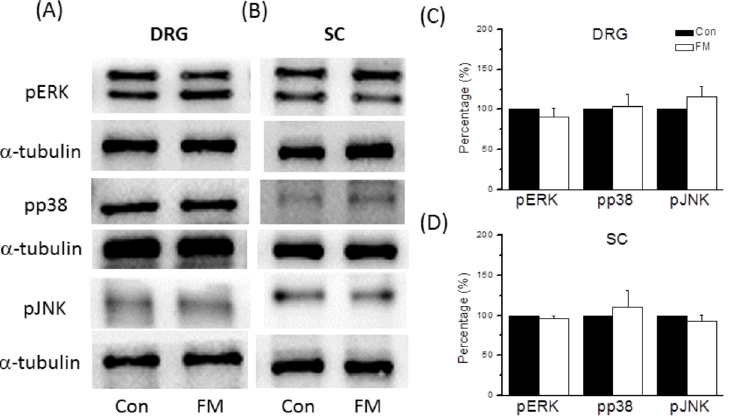
Fig 8. Expression levels of pERK, pp38, and pJNK in L3-L5 DRG from TRPV1 null mice. (A) Western blots of DRG lysates probed for pERK, pp38, and pJNK. (B) Expression levels of pERK, pp38, and pJNK were unchanged at 15 min after injection. α -tubulin was the internal control. Con = Control; FM = acid induced FM pain.